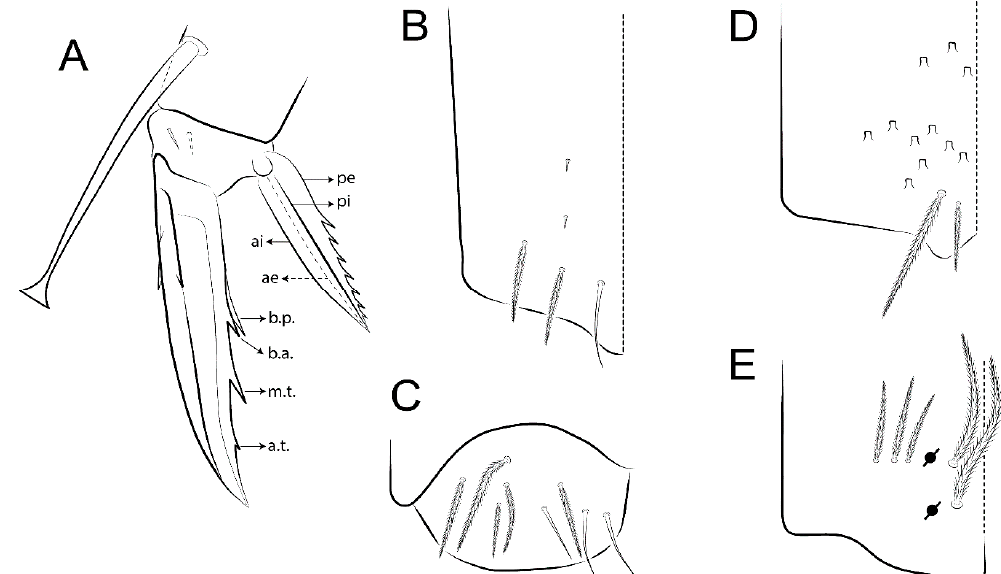
Figure 65. Pseudosinella ambigua : appendages. ( A ) distal tibiotarsus and empodial complex III (anterior view); ( B , C ) collophore: ( B ) posterior side, ( C ) lateral flap; ( D , E ) manubrium: ( D ) ventral side distally, ( E ) manubrial plate (dorsal view).